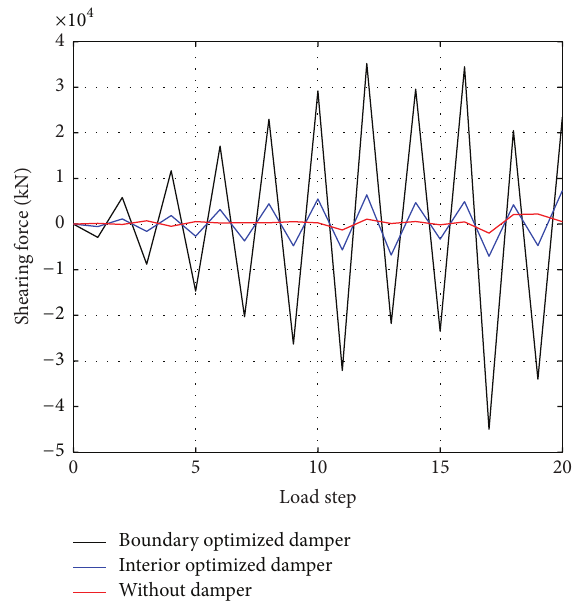
Figure 25: Comparison of force